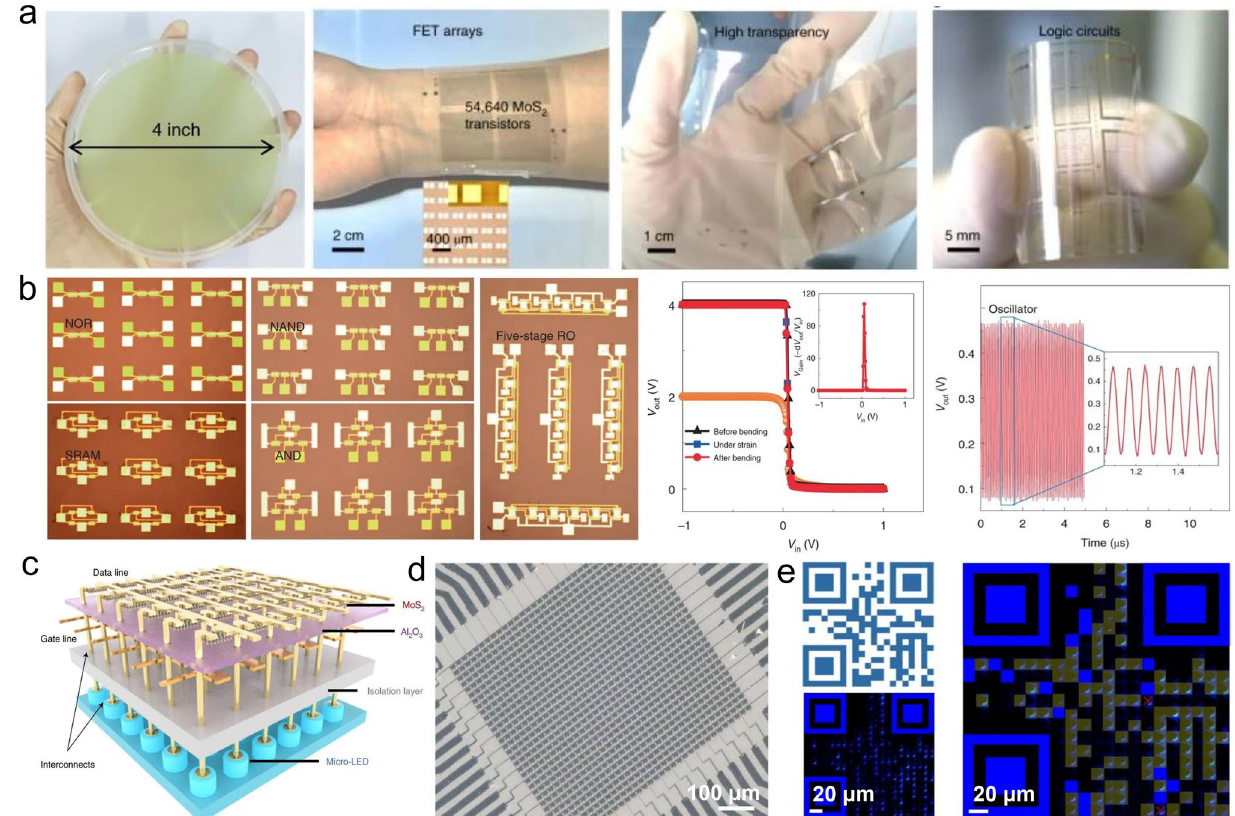
Fig. 11 Application of MoS 2 film in integrated circuits. a The wafer-scale growth of MoS 2 and its optical image of flexible devices, b The circuits of MoS 2 -based NOR, NAND, SRAM, AND and Five-stage RO circuits and the performance of inverters and oscillators [3], Copyright 2020, Springer Nature. c , d The diagram and optical image of the MoS 2 transistor derived micro-LED display, e The images of the QR code dis- played on a 1270-PPI blue micro-LED display [154], Copyright 2021, Springer